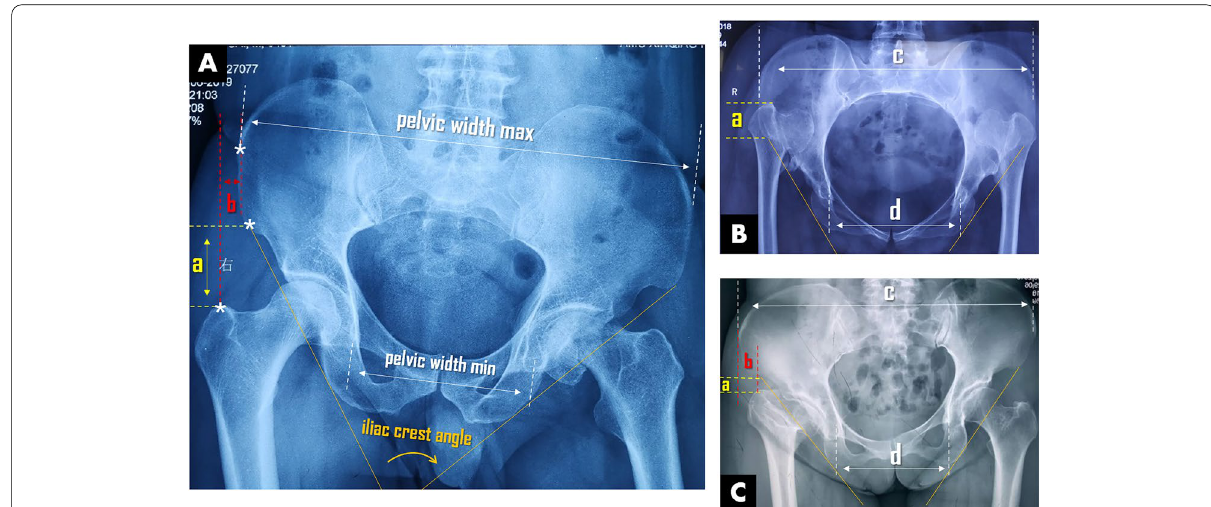
Fig. 1 Pelvic anatomy-related indicators for evaluating feasibility of DAA and their measurement on a standard anteroposterior pelvic X-ray. A Left femoral neck fracture in a pelvis with normal anatomy related-index is strongly indicated for both DAA beginner and expert. B Bilateral high-dislocated developmental dysplasia of the hip in a pelvis with abnormal anatomy related-index is conditionally indicated for DAA expert. C Infection sequela of the right hip in a pelvis with abnormal anatomy related-index is fairly indicated for DAA beginner. Symbol illustration: a, the distance from inferior AIIS to superior GT (abbreviated as D GT-AIIS /D FH ); b, the distance from lateral ASIS to lateral GT; c, pelvic width max, the maximal distance between bilateral ASIS; d, pelvic width min, the minimal distance between bilateral teardrop. Iliac crest angle, the angle between lines connecting the AIIS and the ischial